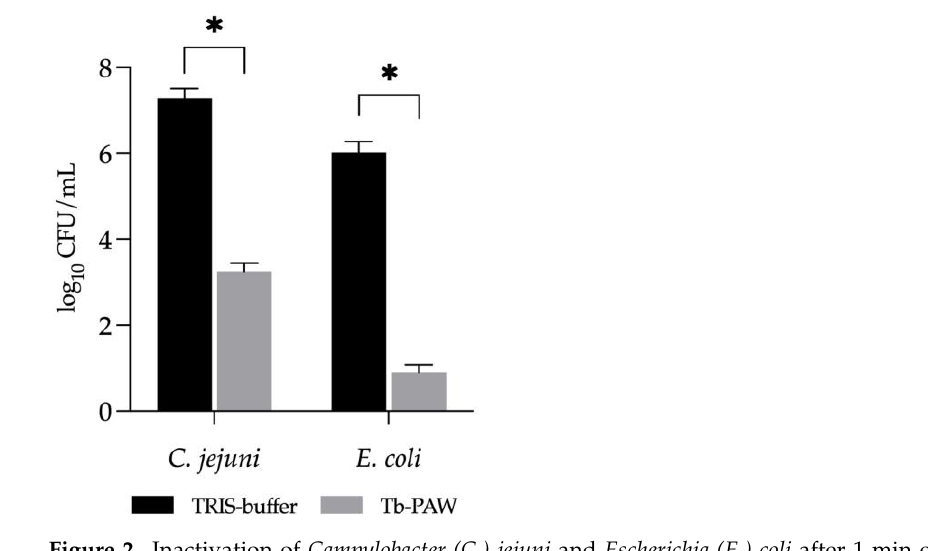
Figure 2. Inactivation of Campylobacter (C.) jejuni and Escherichia (E.) coli after 1 min of Tb-PAW treatment. Results represent the mean ± standard deviation. Significant differences are defined as * p ≤ 0.05. Tb-PAW = TRIS-buffered plasma-activated water.